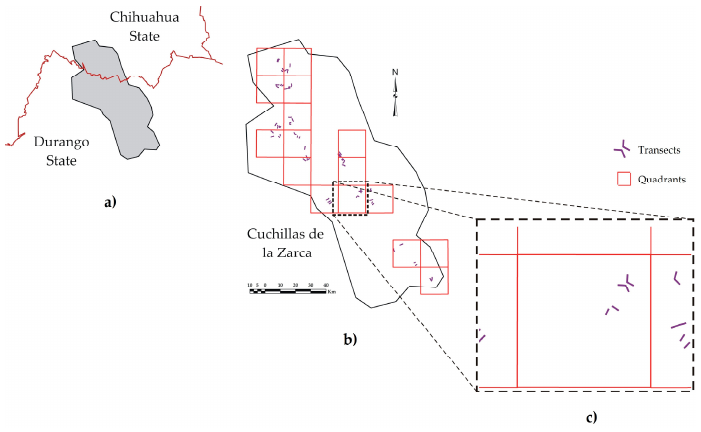
Figure 2. Spatial location of the samples within the study area.